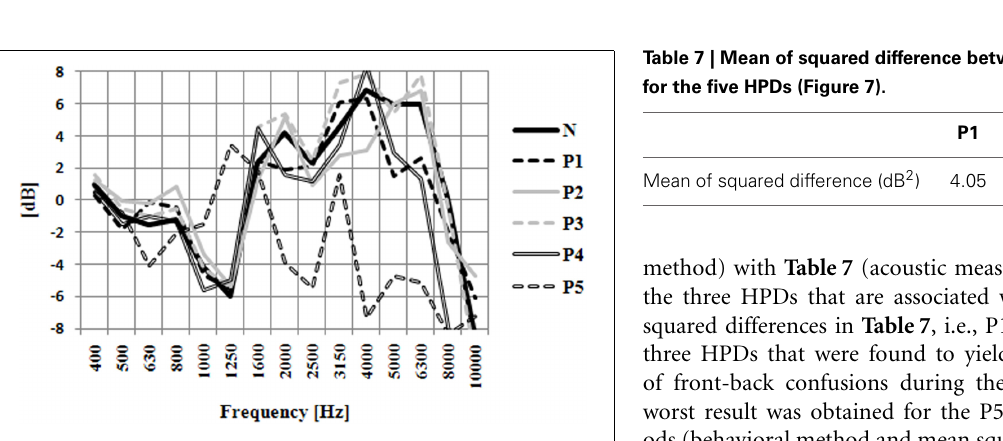
FIGURE 7 | Differences in the ISD cues between the 45 and 135 ◦ orientation for the right ear.